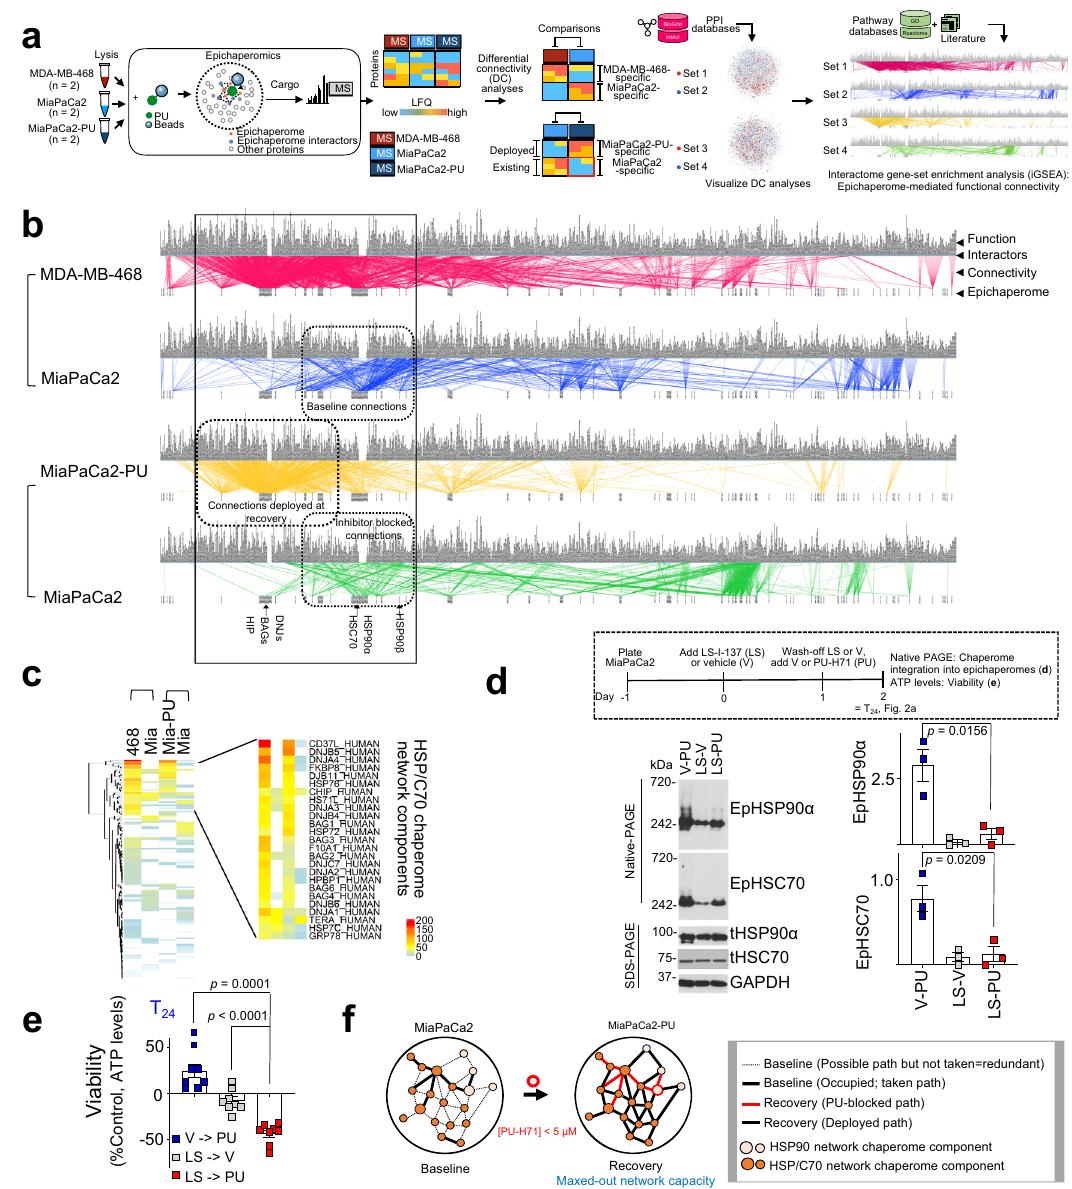
p = 0.0001 Baseline (Possible path but not taken=redundant) Baseline(Occupied; taken path) Fig. 3 Recovery is a state of interactome hyperconnectivity and maximal network capacity executed by integration of chaperome networks. a Schematic of systems level analyses to determine the number of connections and the functional outcome of connections established by the epichaperome and its interacting proteome. b Epichaperome-proteome functional connectivity maps. Each chaperome unit of the epichaperomes is listed at the bottom of the map (see label, epichaperome), paths established between the epichaperome and proteome are depicted by a line (see label, connectivity), and the functional output of each connection is listed on top (see label, function). Connectivity maps are created by differential analysis to emphasise the difference in baseline PPI networks (MDA-MB-468 vs MiaPaCa2) and between baseline and recovery states (MiaPaCa2 vs MiaPaCa2-PU). c Cluster analyses identify components of the HSP/C70 chaperome network as key epichaperome effectors of the bypass connections established at recovery. Scale bar, number of functional connections. d LS-I-137 (LS), an allosteric HSP/C70 binder, blocks HSC70 incorporation into epichaperomes and limits deployment of redundant paths. LS, 250 nM; PU, 1 µ M. Each data point is an independent experiment. Error bars mean ± SEM; unpaired two-tailed t test. e Viability of cells treated as in ( d ). Error bars mean ± SEM; n = 8 biological replicates from 3 independent experiments, one-way ANOVA with Dunnett ’ s post-hoc. f Schematic summary of the fi networks are generated through experimentation (i.e., physical determination of binding interactors) combined with PPI database mining.